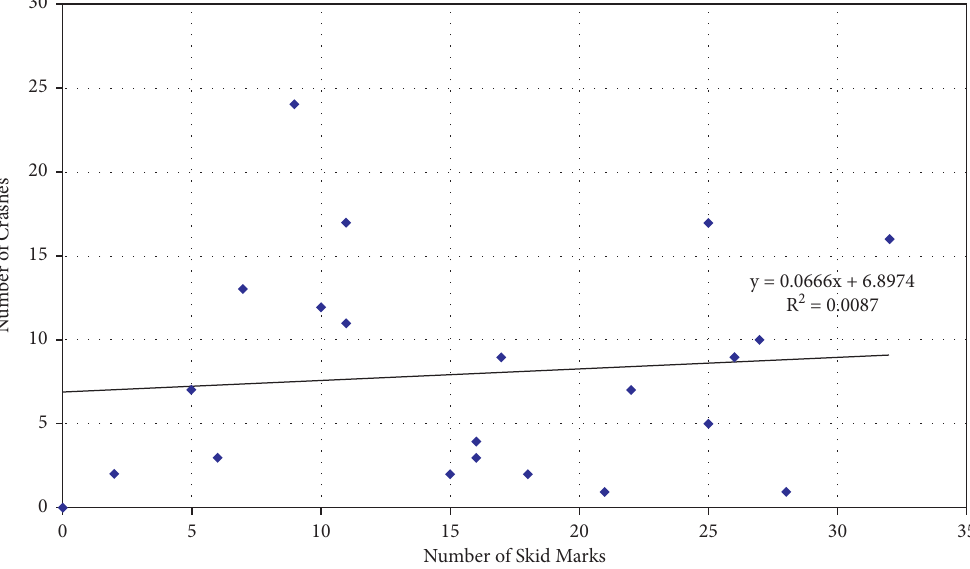
Figure 19: Crash vs. skid correlation at Interstate 80 eastbound ramps.